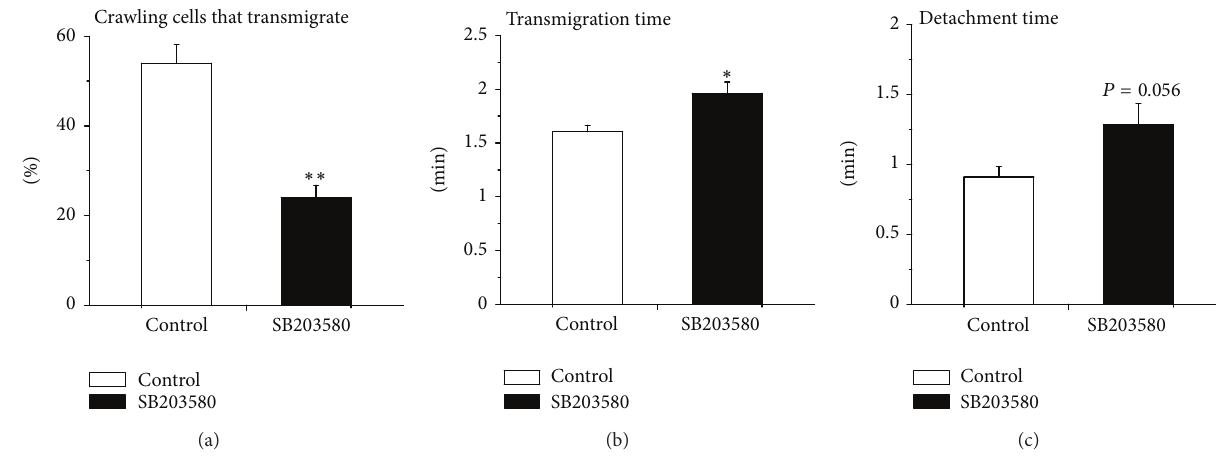
Figure 4: Effect of SB203580 on parameters of KC-induced neutrophil transmigration. (a) The percentage of crawling cells that transmigrate acrosstheendotheliumuponstimulationwithKCintheabsence(control,white)andinthepresence(black)ofp38MAPKinhibitorSB203580 (100nM) 30min prior to and 60 min following the placement of KC-containing gel. Data are means ± SEM ( 𝑛 = 5 ). ∗∗ indicates significant difference ( 𝑃 < 0.01 ) from the control without SB203580 ( t -test). (b) The duration (min) of neutrophil transmigration across the endothelium upon stimulation with KC in the absence (control, white) and in the presence (black) of p38 MAPK inhibitor SB203580 (100nM) 30min prior to and 60min following the placement of KC-containing gel. Data are means ± SEM ( 𝑛 = 5 ). ∗ indicates significant difference ( 𝑃 < 0.05 ) from the control without SB203580 ( t -test). (c) Detachment time (min) of transmigrated neutrophils from the venule upon stimulation with KC in the absence (control, white) and in the presence (black) of p38 MAPK inhibitor SB203580 (100nM) 30 min prior to and 60min following the placement of KC-containing gel. Data are means ± SEM ( 𝑛 = 5 ). The statistical difference between the two groups was found to be 𝑃 = 0.056 (not significant; t